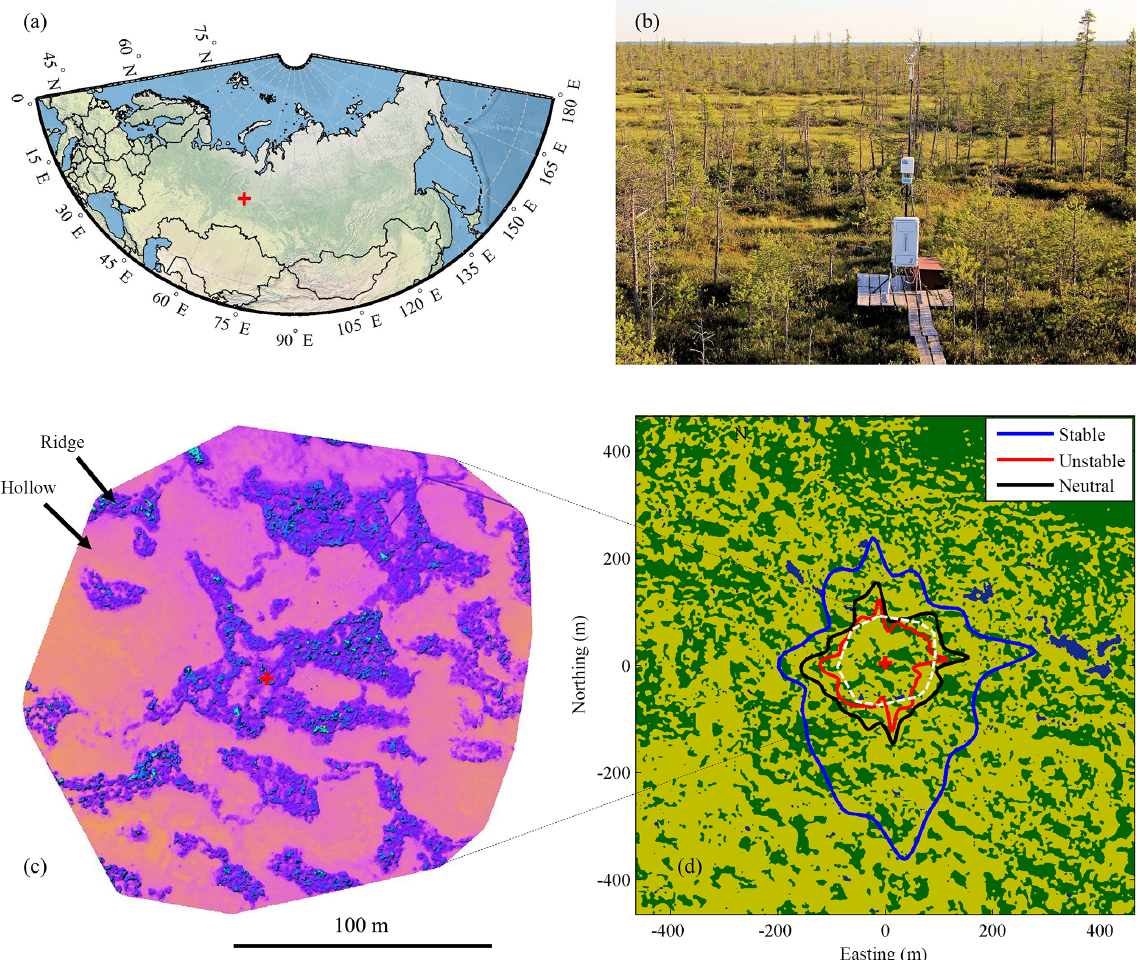
Figure 1. (a) Map showing the Mukhrino station location, (b) photo of the EC tower facing southwest, (c) digital elevation map based on drone survey, and (d) surface-type classification map. (d) Includes an eddy covariance footprint overlay, with the isolines giving the 70% cumulative EC source zone in the three stability classes. Colour coding in (d) is as follows: dark green is ridges–hummocks, light green is lawns–hollows, and dark blue is ponds. The red cross marks the location of the EC